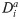

Dia, the measure of amino acid conservation.A, A plot of Dia as a function of fia, the amino acid frequency, and qa, the background frequency here for illustration set to 0.05. See the Supplementary Information for actual values of q.